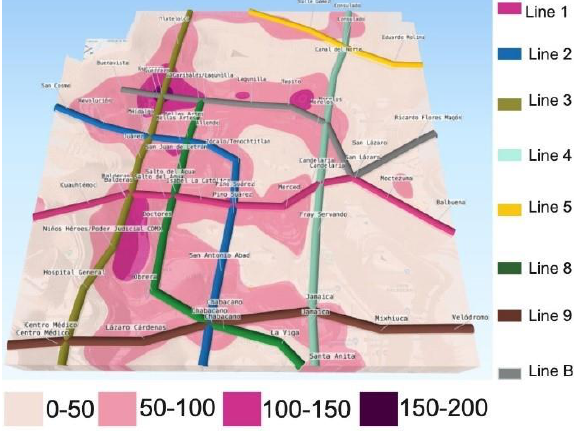
Figure 9. Heatmap of gender-based crimes on subway lines in CDMX.